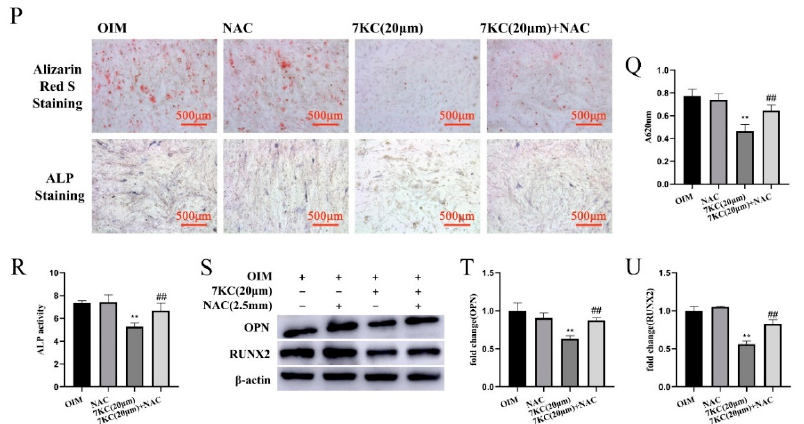
Figure 4. NAC inhibited oxiapoptophagy and differentiation in 7KC-induced MC3T3-E1 cells. ( A ) Cells were prepared for staining with DCFH-DA and DAPI, respectively, and analyzed by a fluo- rescence microscope (×200 magnification). ( B ) The production of ROS was analyzed by fluorescence intensity. ( C , D ) SOD activity detection and MDA level measurement were conducted using the kits. ( E , F ) The protein expression of NOX4 was analyzed by Western blot. ( G – J ) The protein expression of LC3I/II, Beclin1, and P62 was detected. ( K – M ) The protein expression of Bax/Bcl-2 and cleaved caspase-3 was measured. ( N , O ) Apoptosis analysis was conducted by flow cytometry. ( P – R ) ALP activity detection and the mineral assays were performed (×50 magnification) and analyzed. The protein expression of OPN ( S , T ) and RUNX2 (S,U) was determined by Western blotting. Data were analyzed for comparison with the OIM group. ** p < 0.01. Compared with the 7KC (20 μ M) group, ## p < 0.01. OIM, osteogenic induction medium; NAC, 2.5 mM NAC.